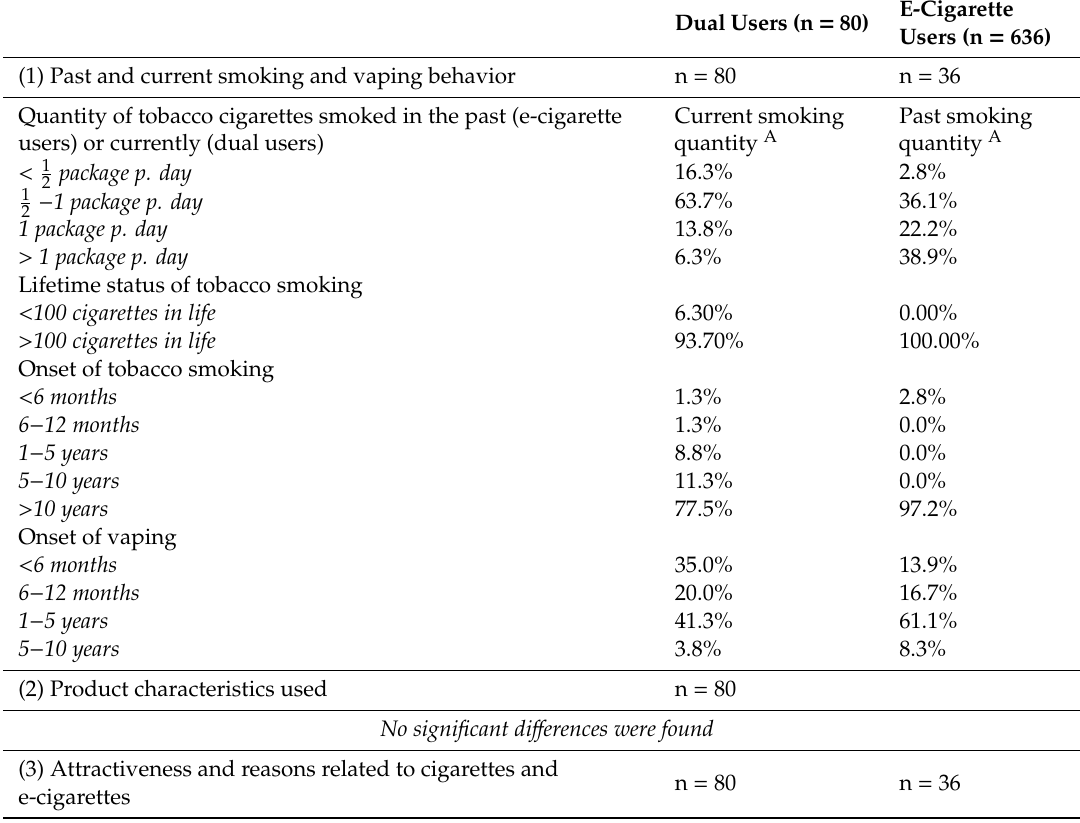
Table 1. Significant di ff erences between dual users and exclusive e-cigarette